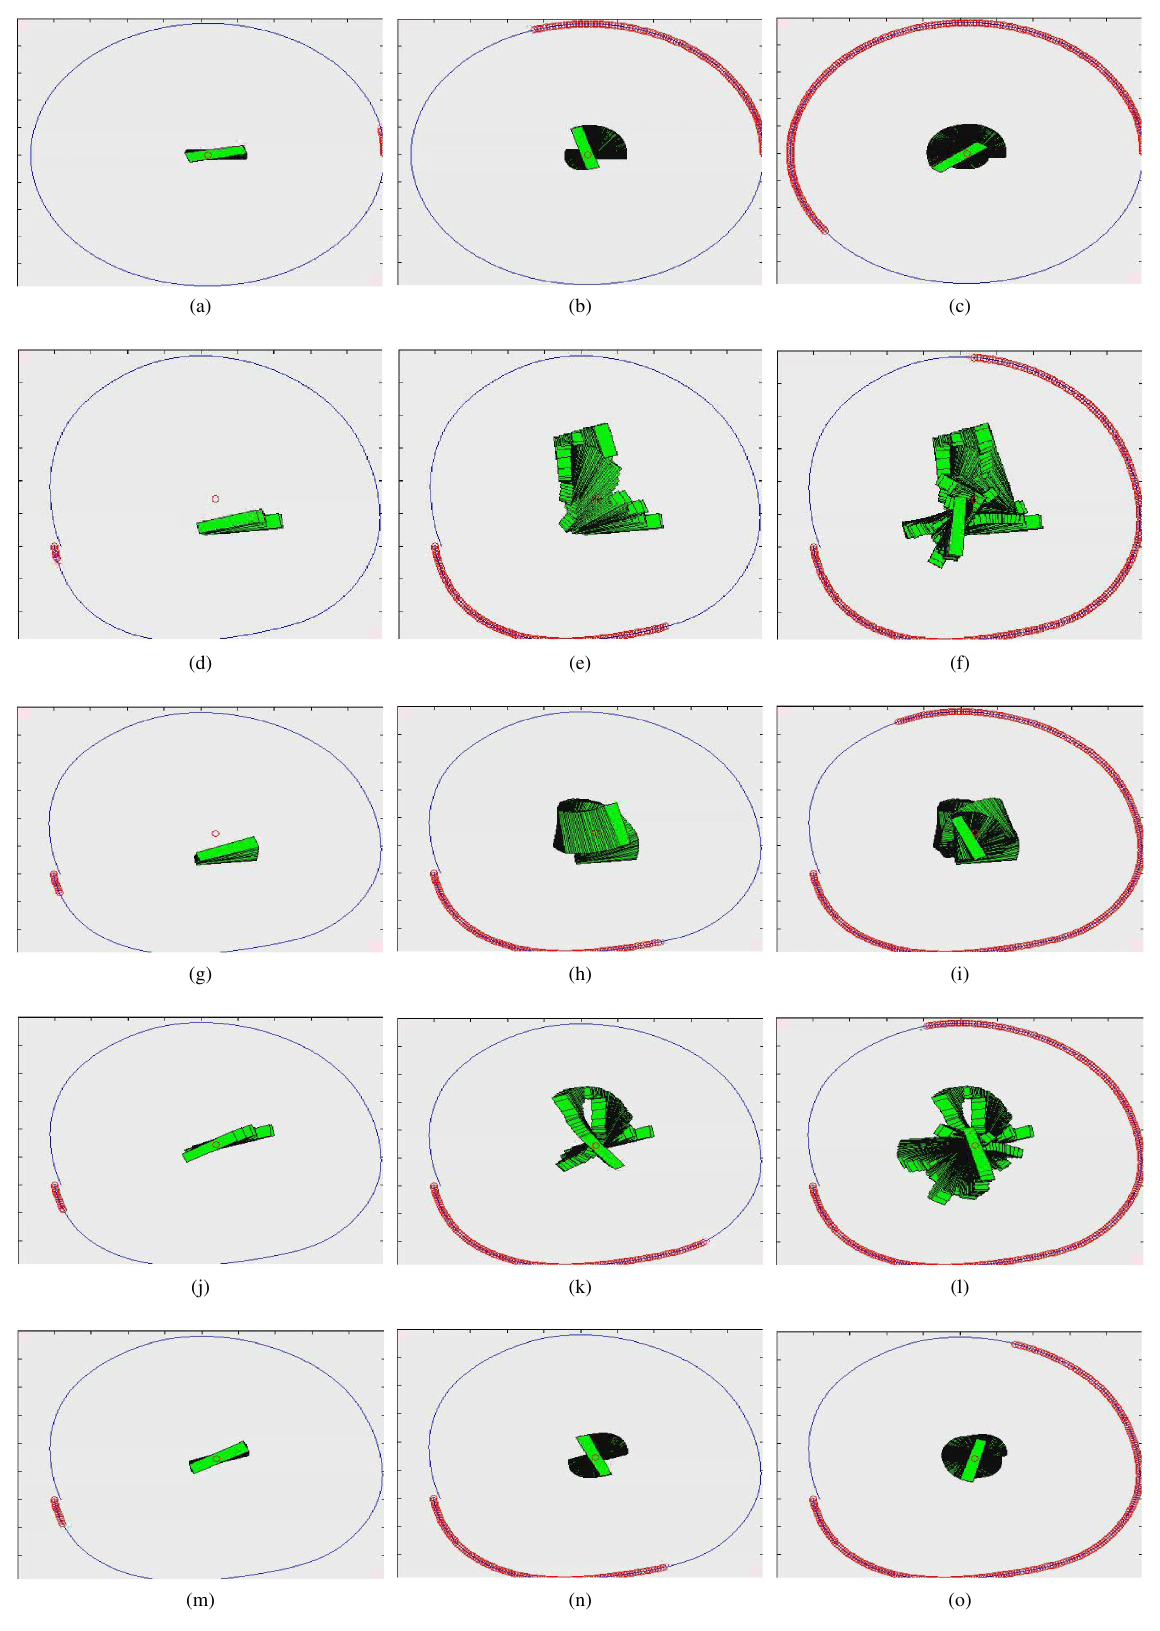
Figure 5: Flight and beam pattern visualization of experimental data. Images taken from a continuous video sequence from left to right. Flight trajectory is marked blue, actual position and already covered distance of airplane is marked red, instantaneous radar footprint is simulated green and continuously overlapped. (a-c):Ideal simulated circular trajectory, (d-f): Real experimental data, (g-i): Experimental data stabilized in roll angle, (j-l): Experimental data stabilized in squint angle, (m-o): Experimental data stabilized in pitch, squint and